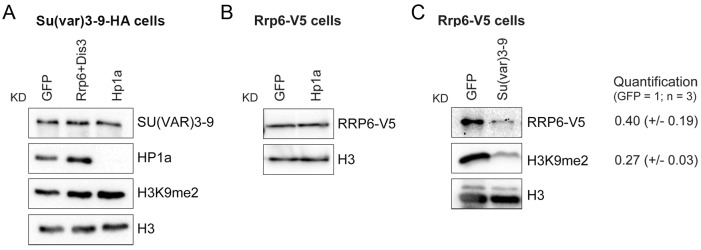
SU(VAR)3-9 depletion affects the association of RRP6 with chromatin.The association of selected proteins with the chromatin was analyzed by Western blotting using native chromatin preparations fractionated according to the scheme in Fig 1F. (A) Analysis of S2 cells that express the HA-tagged SU(VAR)3-9. The global levels of HP1a and SU(VAR)3-9 in the chromatin were analyzed in control cells (GFP) and in cells depleted of RRP6 and DIS3, or HP1a. The chromatin fractions were analysed using different antibodies, as indicated in the figure. An anti-HA antibody was used to detect SU(VAR)3-9. H3 and H3K9me2 served as controls. (B) Analysis of S2 cells that express the V5-tagged RRP6 depleted of HP1a. An anti-V5 antibody was used to detect RRP6 in the chromatin fractions. Depletion of HP1a does not affect the levels of RRP6 bound to the chromatin fraction. (C) Analysis of S2 cells that express the V5-tagged RRP6 depleted of SU(VAR)3-9. An anti-V5 antibody was used to detect RRP6. The quantification of the band intensities from three independent experiments is shown to the right. The standard deviations are given in parentheses. Histone H3 was used for normalization.